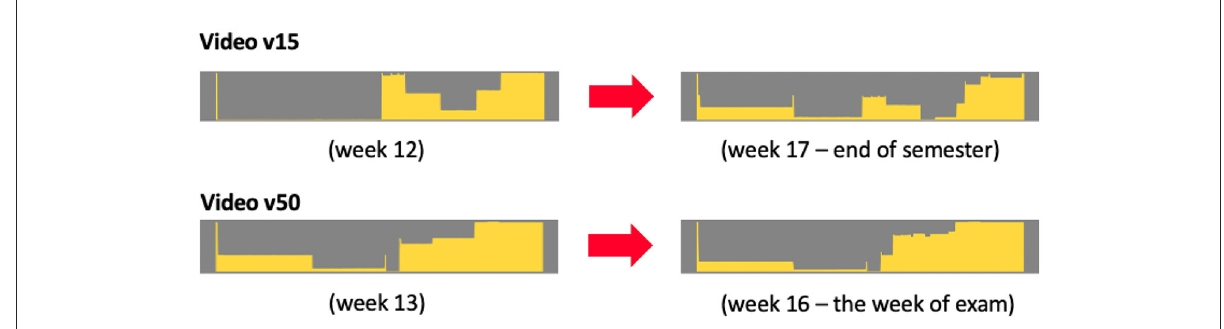
FIGURE4 Timeline changes over time. v15 (duration: 19 m 02 s) at week 12 and just after the final exam; v50 (duration: 9 m 34 s) at the week of final